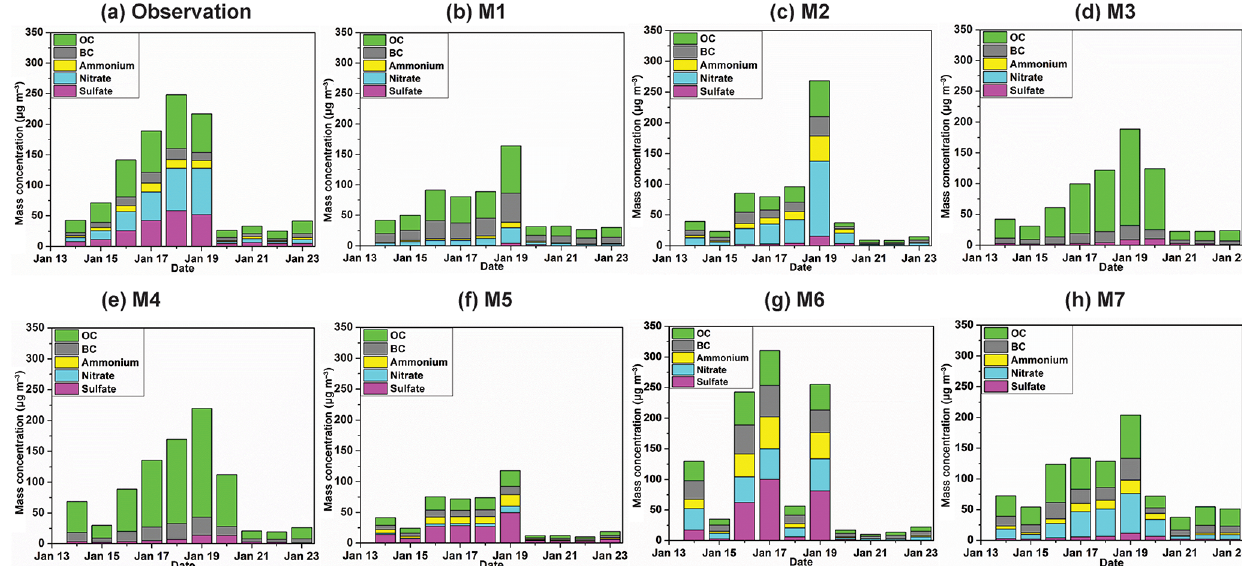
Figure 9. Observed and simulated daily mean concentrations of major PM 2 . 5 chemical components at the urban Beijing